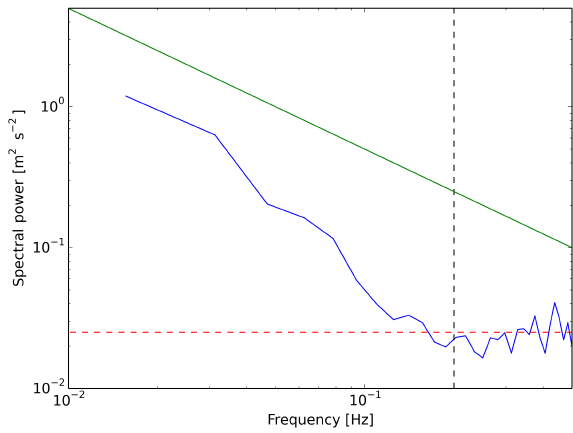
Figure 4. Spectral power for the DWL measured vertical wind speed during the flight on 20 June 2013, between 10:31 and 10:45LT and for an altitude of 2300m (solid, blue). The expected spectral behaviour according to the Kolmogorov’s − 5 / 3 law (green line), the noise frequency threshold (black, dotted) and the derived noise floor for the DWL (red, dotted) are